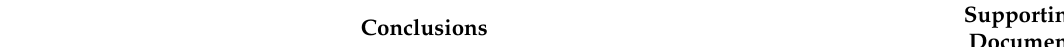
Table 3. Diabetes and stroke research directions, determined by the six